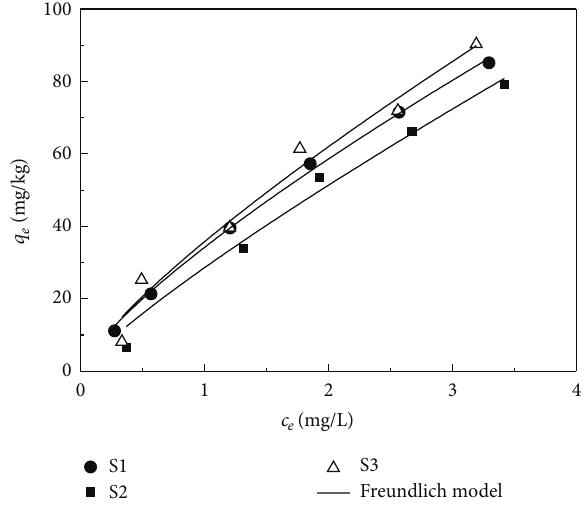
Figure 2: Adsorption isotherms of EE2 in the sediment.